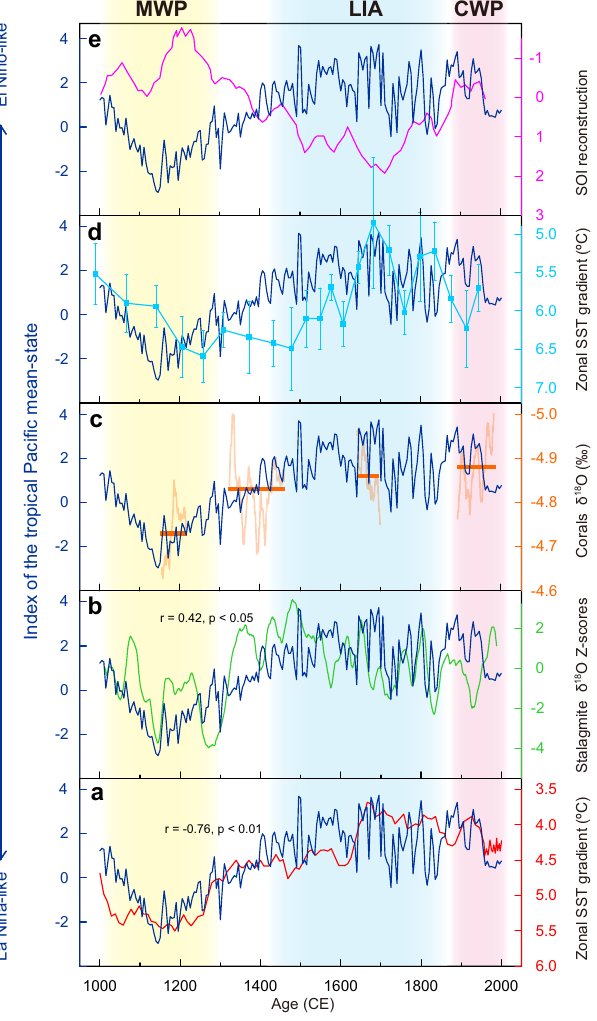
Fig. 3 Comparison of the index of the tropical Paci fi c mean-state reconstructed from East Asian precipitation with other SST pattern reconstructions of the tropical Paci fi c. The index of the tropical Paci fi c mean-state from this study is plotted in each panel with a dark blue line. a Reconstructed zonal SST gradient across the tropical Paci fi c from the combined Indo Paci fi c Warm Pool (IPWP) and eastern equatorial Paci fi c (EEP) SST records 46 (red). b Composite stalagmite δ 18 O Z-scores in the Asian-Australian monsoon region 47 (green). c Coral δ 18 O values from Palmyra Island (6°N, 162°W) in the central tropical North Paci fi c 9 (orange). d Reconstructed zonal SST gradient across the tropical Paci fi c from the combined western Paci fi c warm pool (WPWP) and EEP SST records 14 (light blue). e Reconstructed SOI based on precipitation in the tropical Paci fi c 16 (pink). The yellow shading indicates the MWP, the blue shading indicates the LIA, and the red shading indicates the